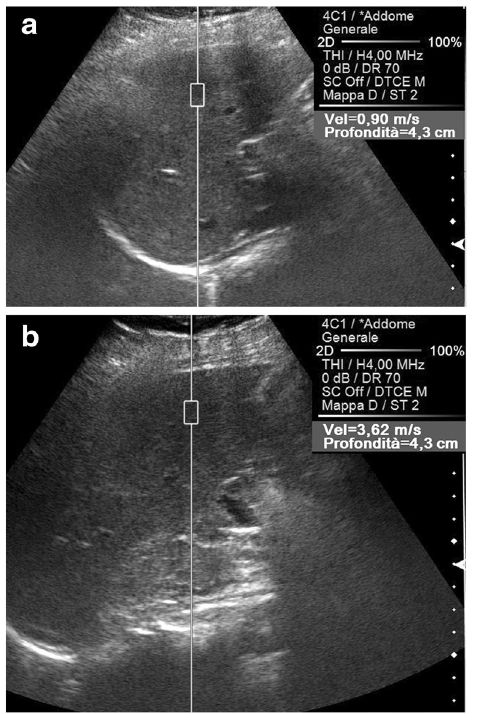
Fig. 10 ARFI evaluation of liver. Transversal US scans on the right lobe of the liver in two different patients with chronic liver disease due to hepatitis virus C. The SWV value is lower (0.90 vs. 3.62 m/s) in a 41- year-old man with fibrosis stage 1 at histology ( a ) than in a 51-year-old man with fibrosis stage 3 ( b